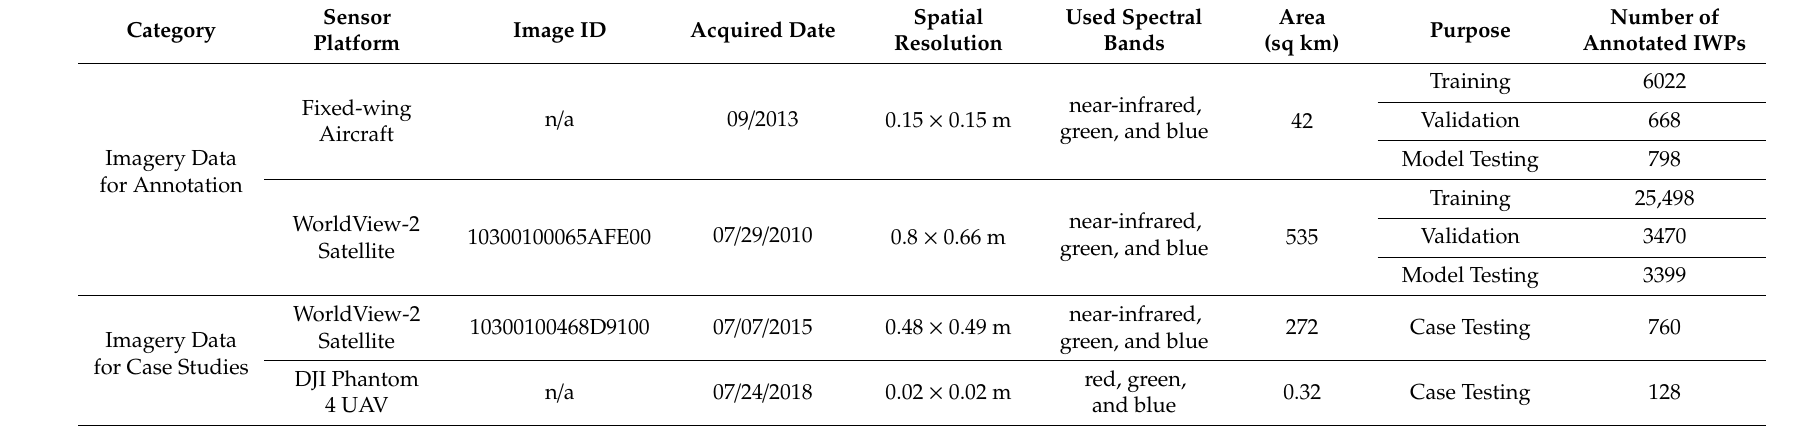
Table 1. Description of used